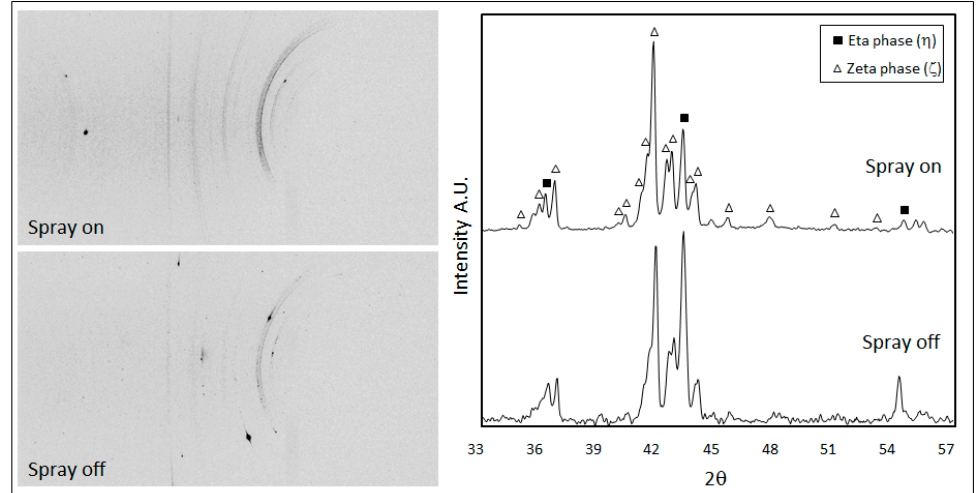
Figure 9. 2D diffraction images and integrated patterns from steel 9A (spray on) and 9B (spray off) samples.